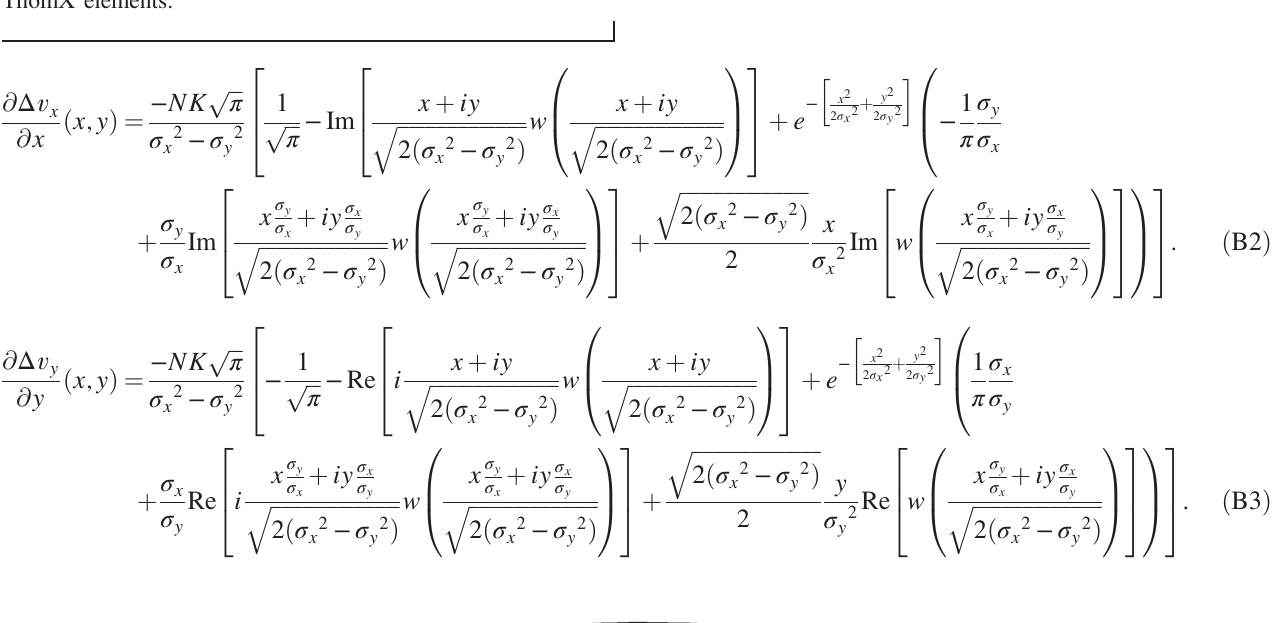
11. Optics functions for half of the ThomX storage ring lattice. The horizontal beta function β x is plotted in red, the vertical beta function β y in blue and the horizontal dispersion times 20 is plotted in green. The bottom plot is a synopsis of the ThomX